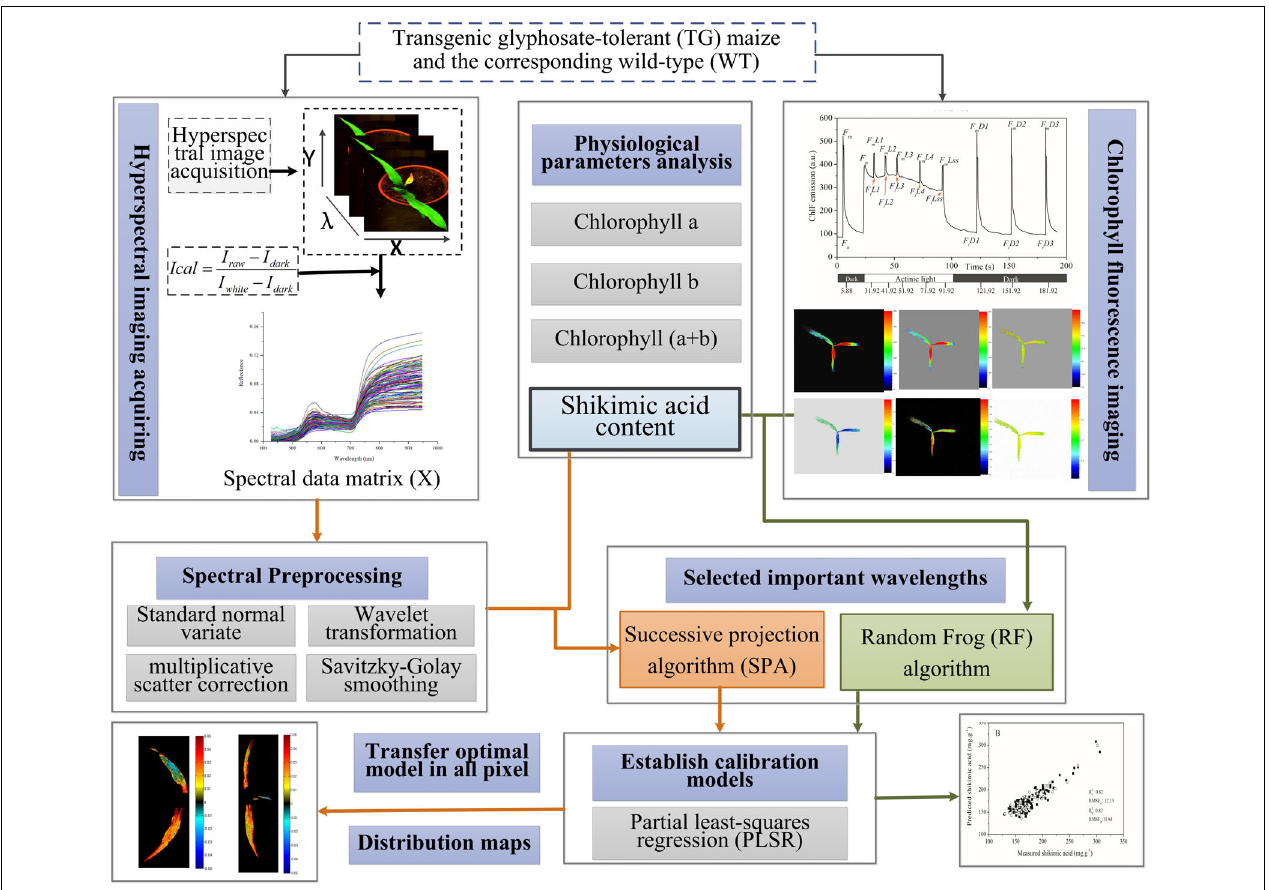
FIGURE 1 | Flowchart of determination of shikimic acid concentration in maize leaves based on chlorophyll fluorescence and hyperspectral imaging.